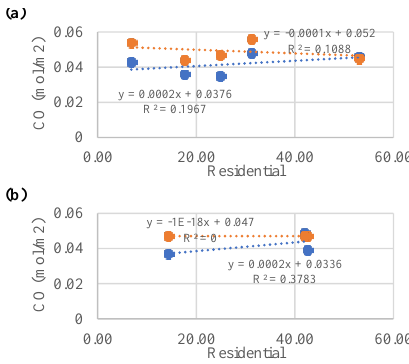
Figure 16. Influence of residential landuse on